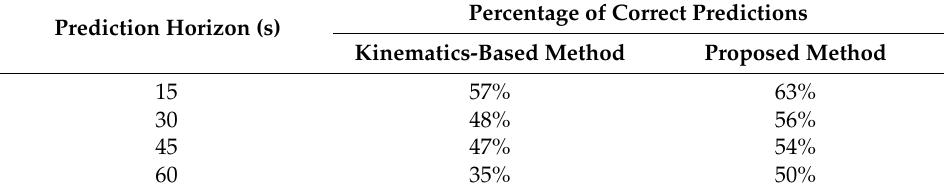
Table 2. Results of the proposed method and kinematics-based method for the Voronoi zoning described in Figure